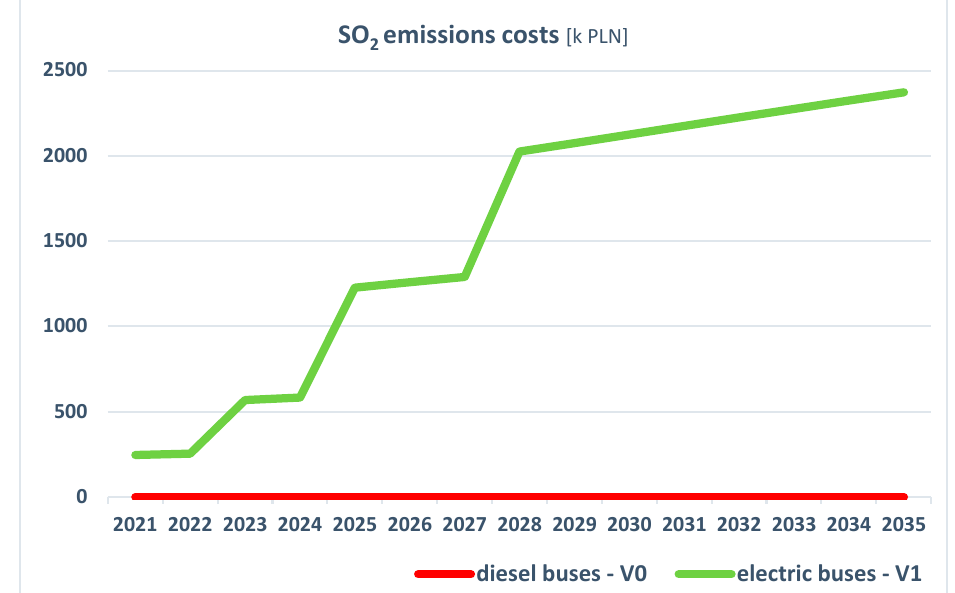
Figure 6. Projected amounts of PM emissions costs of the public bus fleet in Szczecin in the 2021– 2035 period for variants V0 and V1.